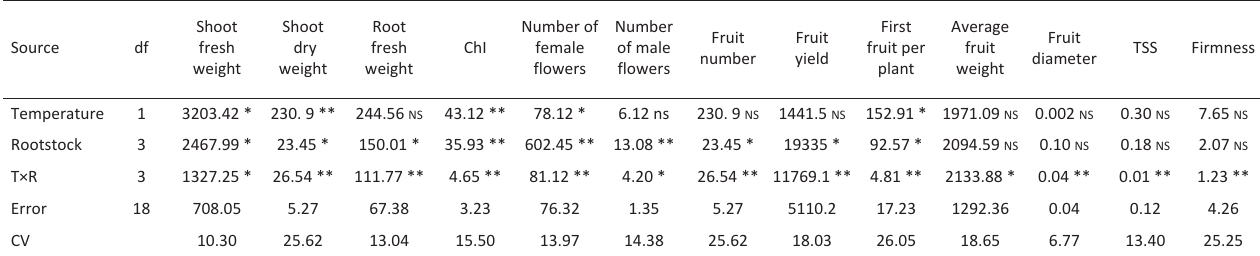
Table 1 a ­ Analysis of variance of the effect of temperature and rootstock on some characteristics of cucumber